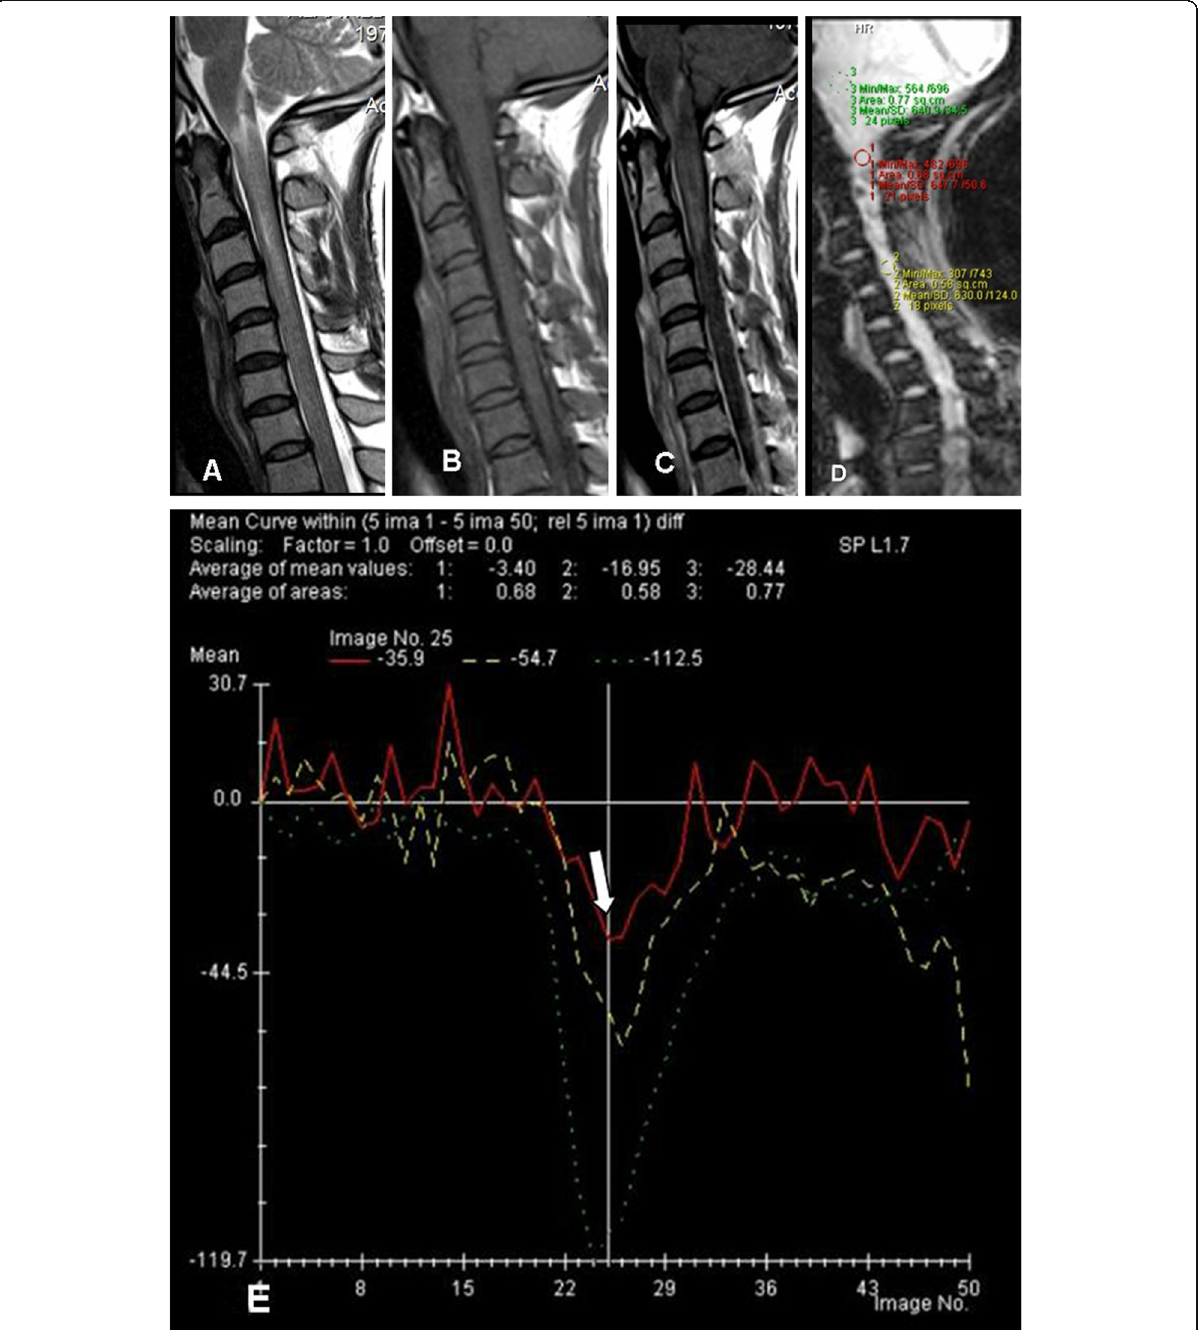
Fig. 1 Thirty-seven-year-old male patient presented by acute onset of bilateral lower limb weakness and neck pain. a Sagittal T2 revealed abnormal T2 hyperintense signal spanning over the cervicomedullary junction till CV4 level. b T1W pre and c post contrast showing faint patchy enhancement. d rCBV was calculated in relation to the normal lower cervical cord, showing e hypoperfusion ( arrow to red curve ) compared to the normal cord ( yellow curve ), suggesting non-neoplastic inflammatory process. Green curve indicates the pons. Initial clinical diagnosis of viral myelitis (zoster) due to appearance of skin eruptions, the patient improved clinically, confirming its non-neoplastic